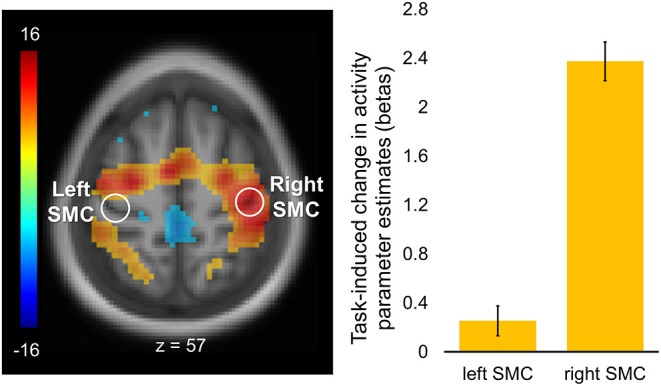
Regions of interest and task-induced changes in activity. A statistical map of the whole-brain analysis of task-induced changes in activity was thresholded at p < 0.05 (two-tailed) using peak-level family-wise error (FWE) correction over the entire brain. The map is displayed over the mean structural image of all participants. Color bar represents t values with yellow-red and green-blue shades indicating regions with task-induced activity increases and decreases, respectively. Regions of interest (ROIs, white circles) were defined as spheres (r = 6 mm) within the hand area of the left (“passive”) and right (“active”) somatomotor cortex (SMC; xyz = −36, −24, 57, and xyz = 42, −21, 57, respectively). Columns represent group mean of task-induced increases in activity for each ROI. Error bars represent standard errors of the mean (s.e.m.).